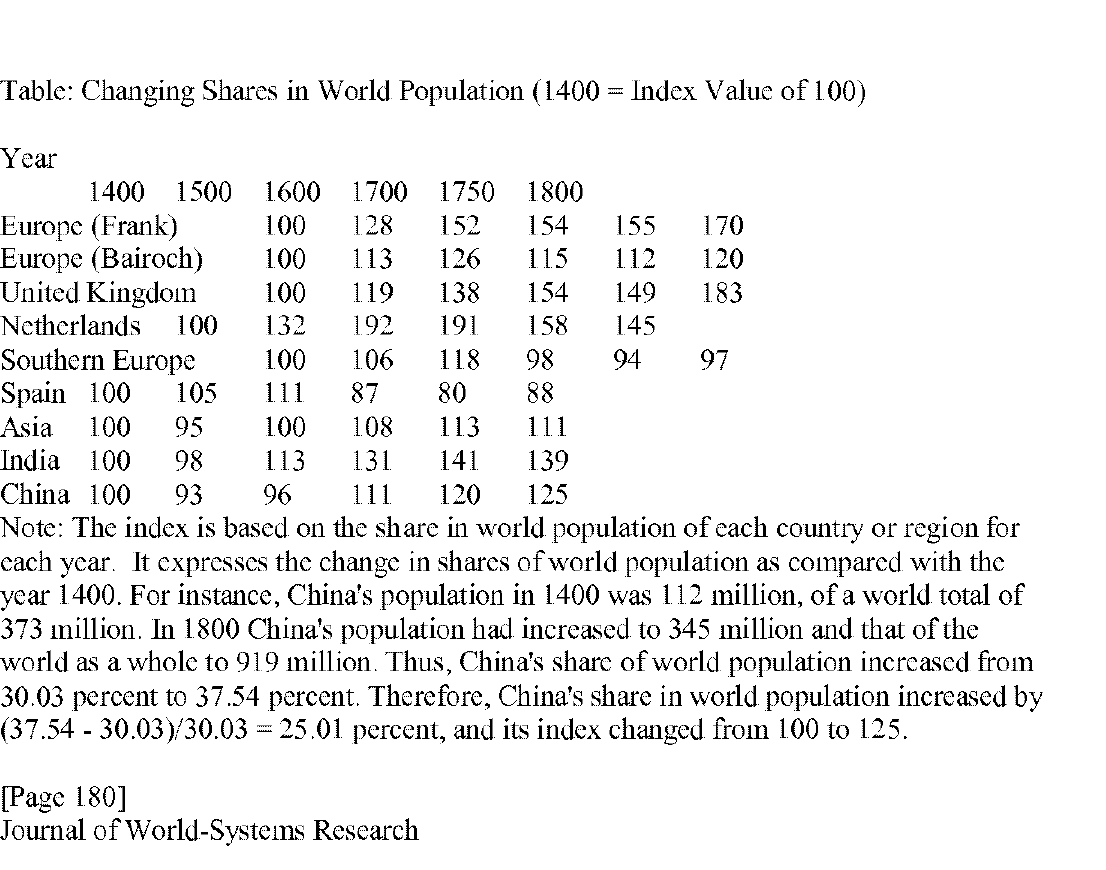
Table: Changing Shares in World Population (1400 = Index Value of I